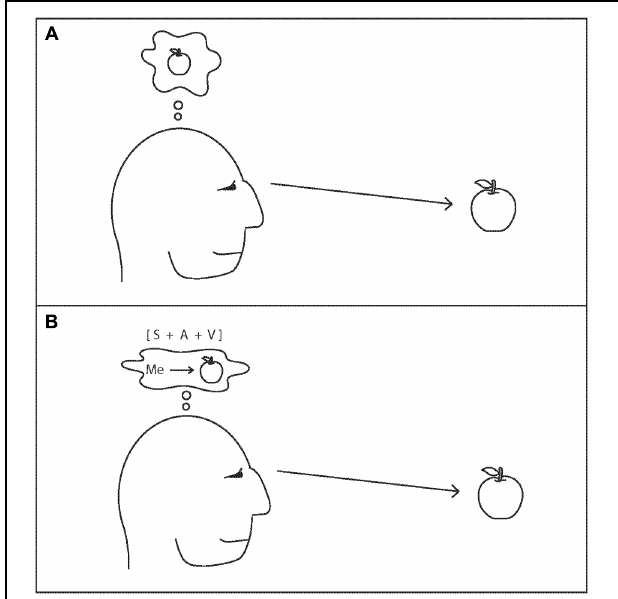
FIGURE 1 | The attention schema theory. (A) Visual attention is captured by the image of an apple. On its own, this process results in the ability